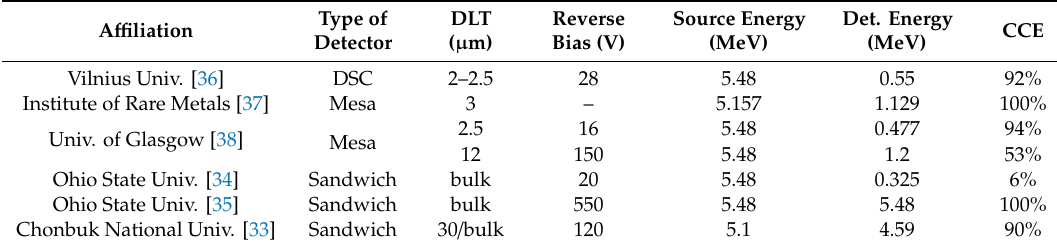
Table 3. The state-of-the-art GaN-based α -particle